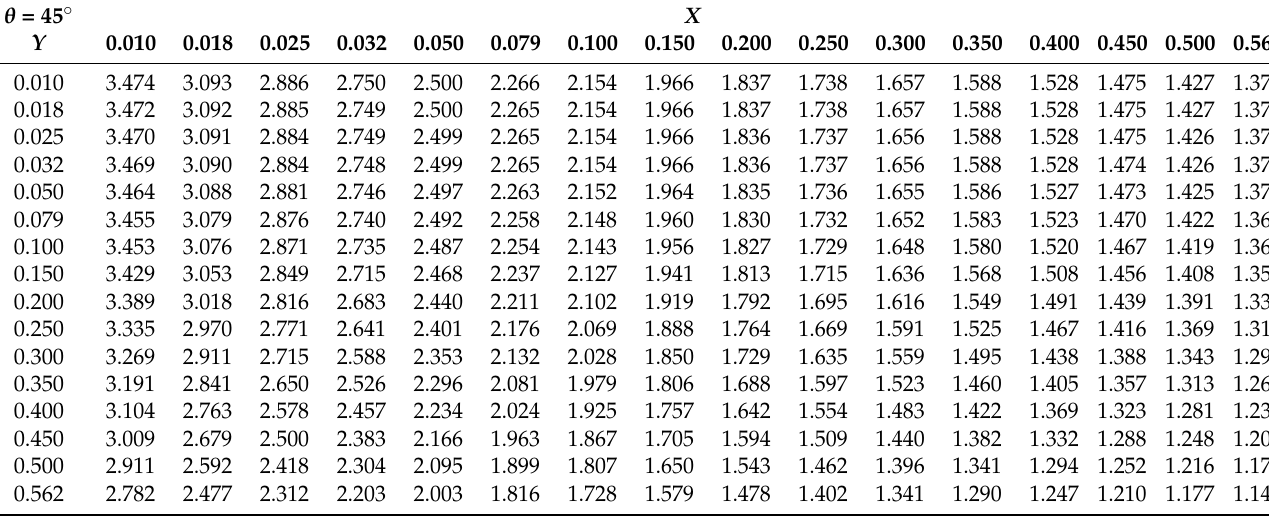
Table 1. Representation of SCF values for a plate T-joint subjected to shearing load, while θ = 45 ◦ and T / a = 1. θ = 45 ◦ X